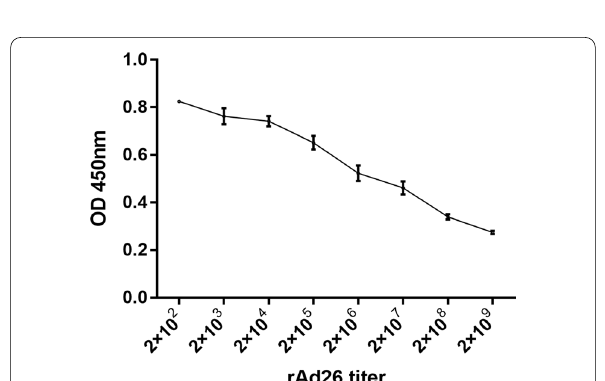
Fig. 10 The affinity constants of recombinant sdAbs 5 to adenovirus rAd26 were determined by competitive ELISA. Affinity constants were expressed as the reciprocal of the adenovirus titer at 50% of the maximum OD450 nm value. The results showed that the 50% of the maximum OD450 nm value was 0.41225, and it can be found that the adenovirus titer at this point was about 5 10 8 vp/ml. Therefore, the × affinity constants of purified clone 5 sdAbs to adenovirus rAd26 were determined to be 2 10 –9 by ×